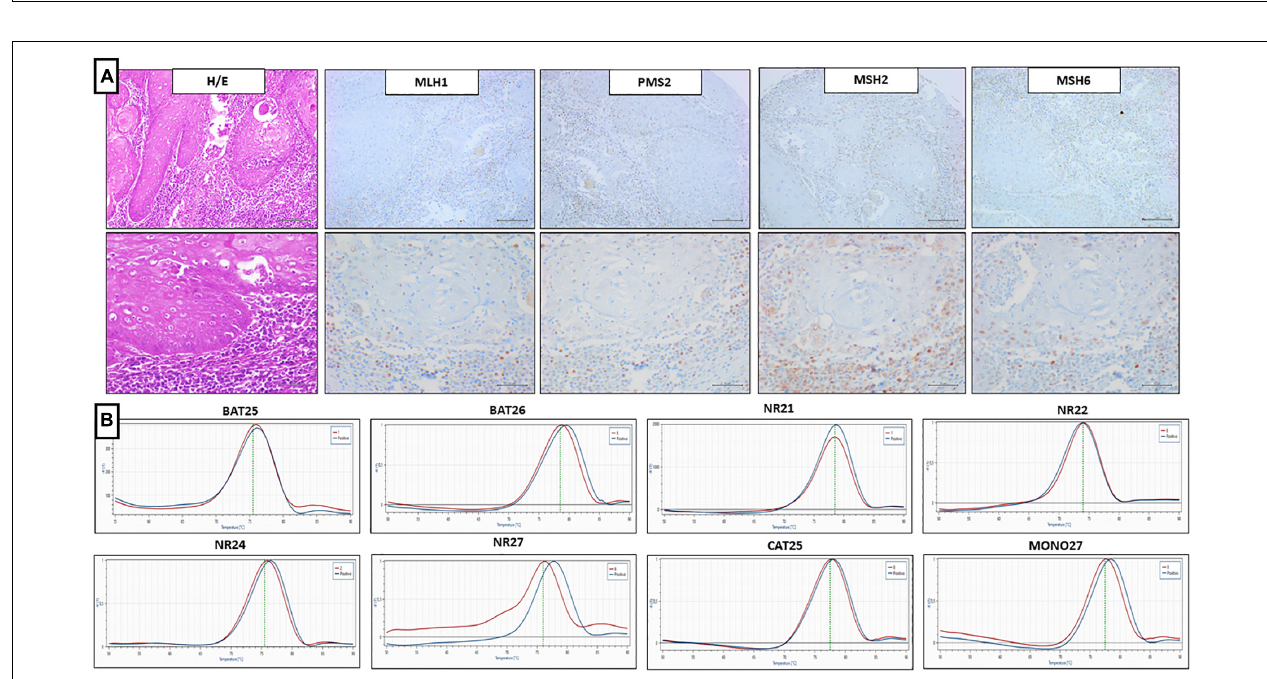
FIGURE 5 | Representative results of penile SCC case showing dMMR IHC and MSI-L by PCR. (A) Upper line (from left to right) MMR-IHC results: Hematoxilin and Eosin penile SCC, loss expression of MLH1 and PMS2, while loss-patchy expression of MSH2 and MSH6 (20x magnification, scale bar = 100 µ m); lower line (from left to right) MMR-IHC results: Hematoxilin and Eosin penile SCC, loss expression of MLH1 and PMS2, while loss-patchy expression of MSH2 and MSH6 (40x magnification, scale bar = 200 µ m). (B) MSI-PCR results: stability of BAT25, BAT26, NR21, NR22, NR24, CAT25, and MONO27, instability of NR27 (red lines indicate samples while blue lines indicate MSS